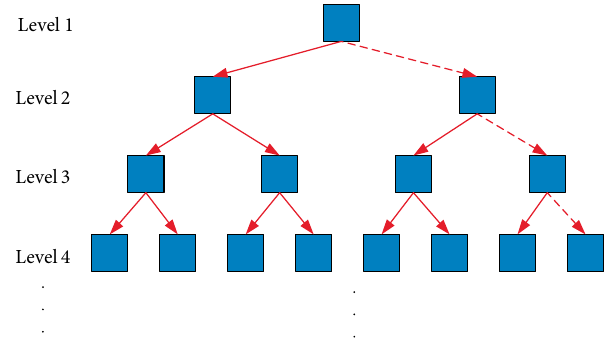
Figure 1: Schematic diagram of the tree structure. The solid line represents the selected global path planning action, and the dotted line represents the local path planning